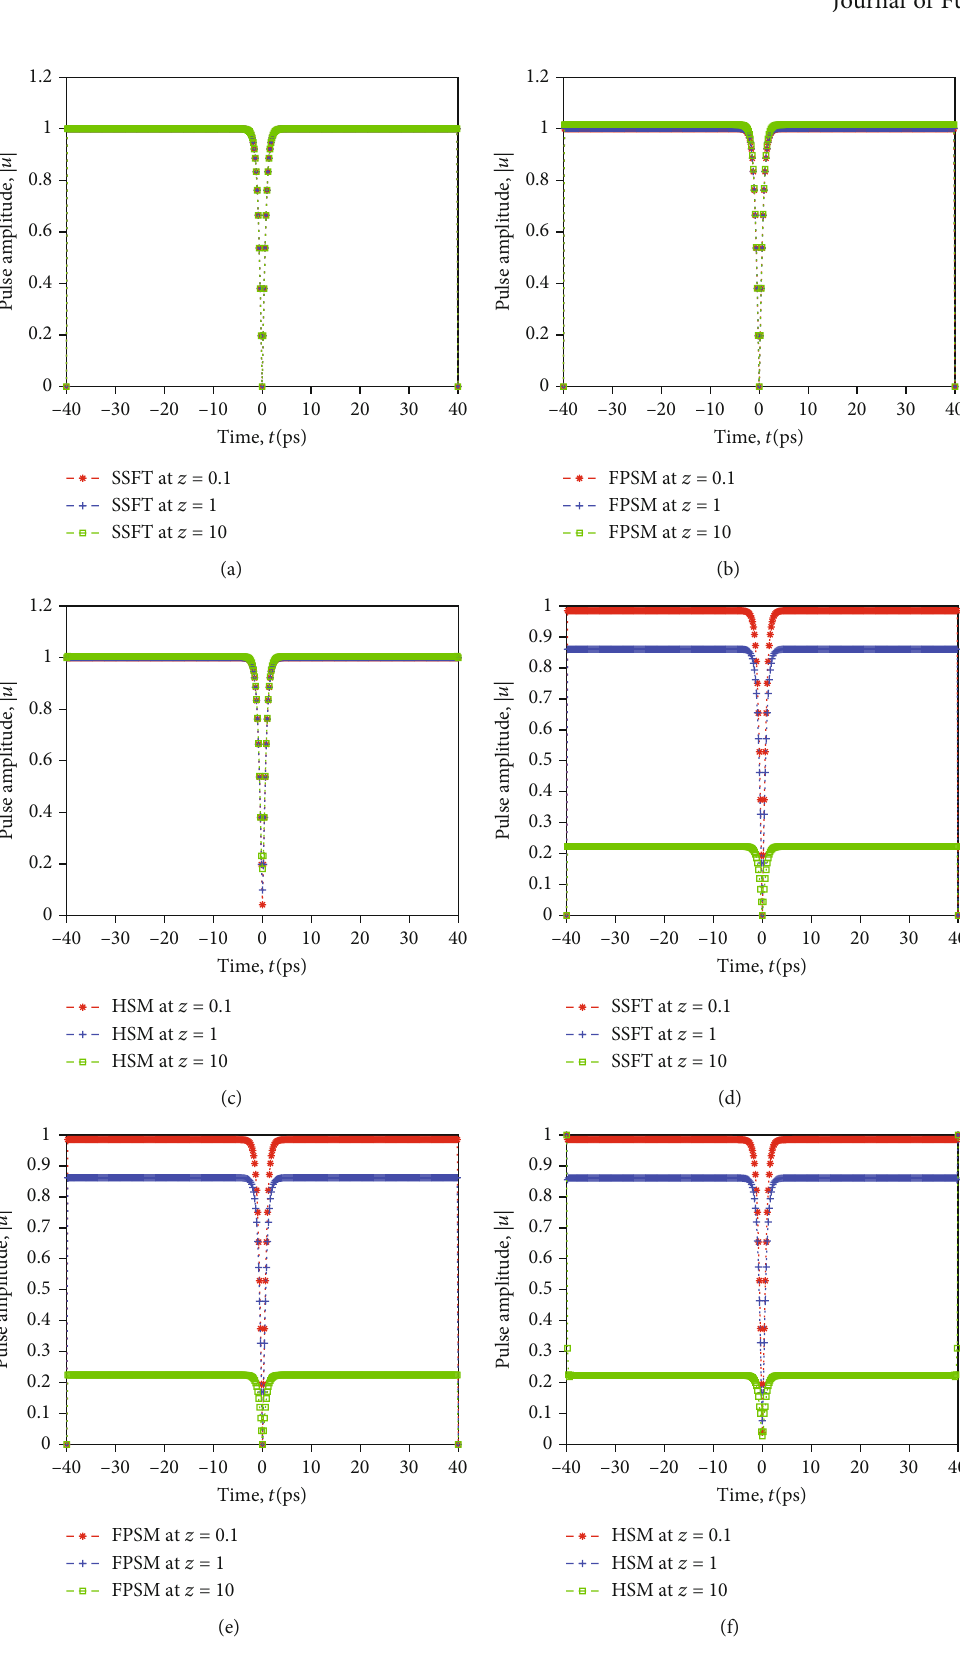
Figure 8: A comparison of the split-step Fourier transform (SSFT), the Fourier pseudospectral method (FPSM), and the Hopscotch method (HSM) approximate solution for a lossless (a, b, c) and lossy (d, e, f) optical fi ber when the input pulse is a dark soliton at distances z = 0 : 1, 1, 10 km,